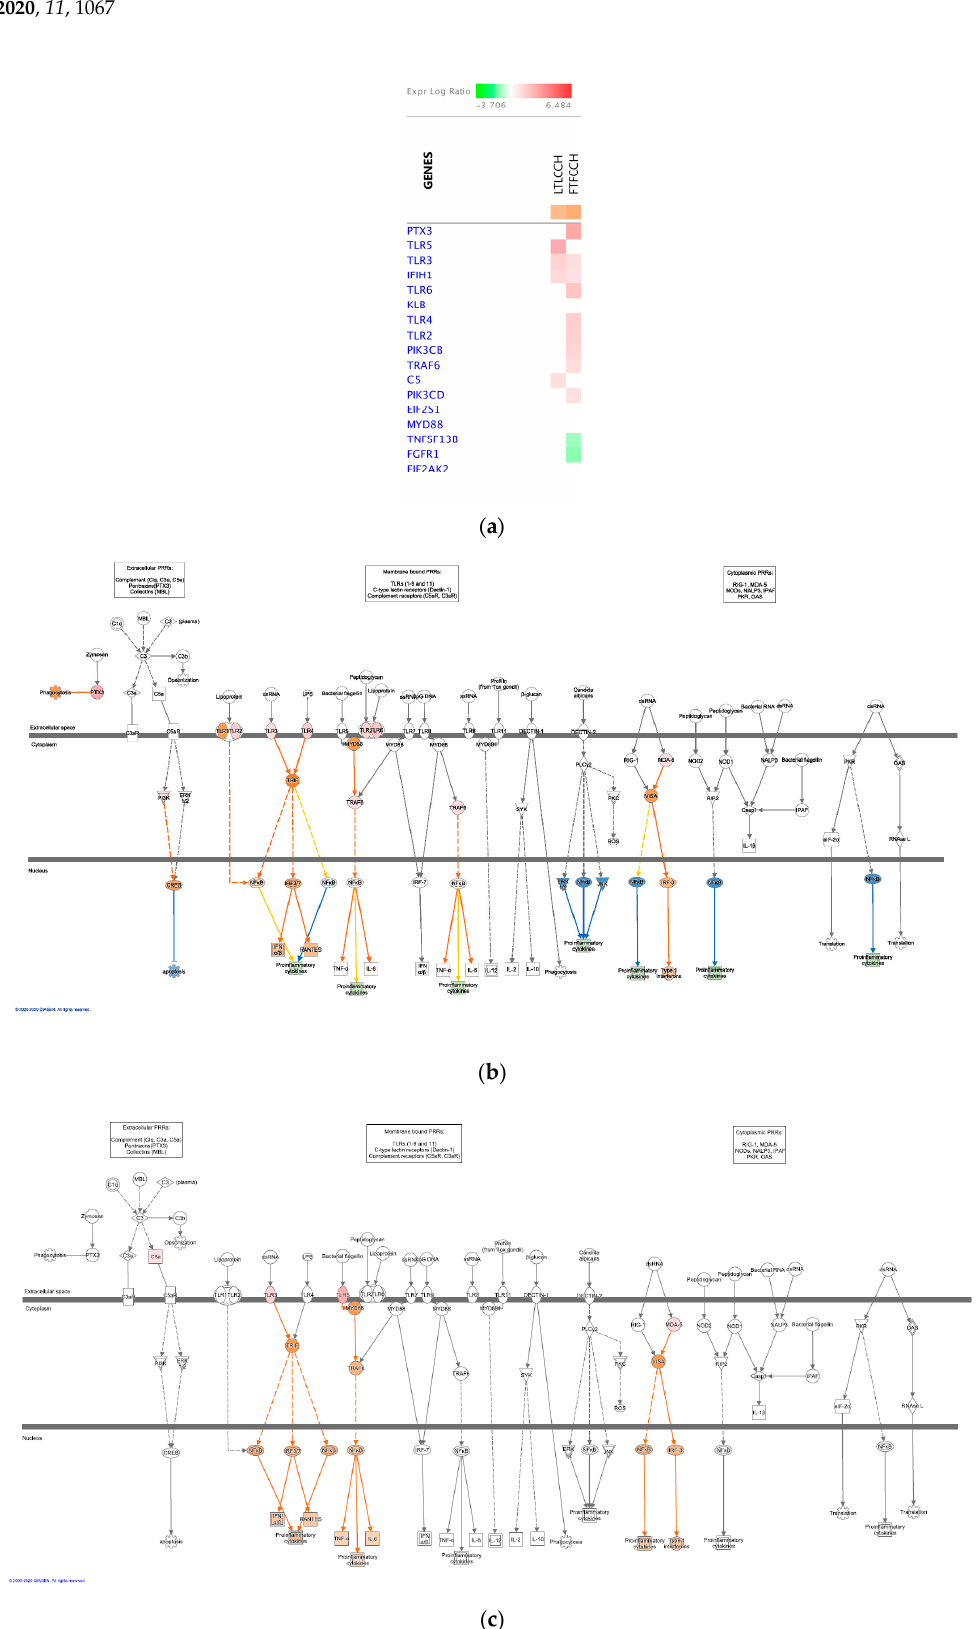
Figure 12. The Role of Pattern Recognition Receptors in Recognition of Bacteria and Viruses pathway in Fayoumi birds and Leghorn birds with NDV infection during chronic heat stress. ( a ) The DEG heatmap matching to the pathway; ( b ) The molecule activity prediction of the pathway in Fayoumi birds with NDV infection during chronic heat stress; ( c ) The molecule activity prediction of the pathway in Leghorn birds with NDV infection during chronic heat